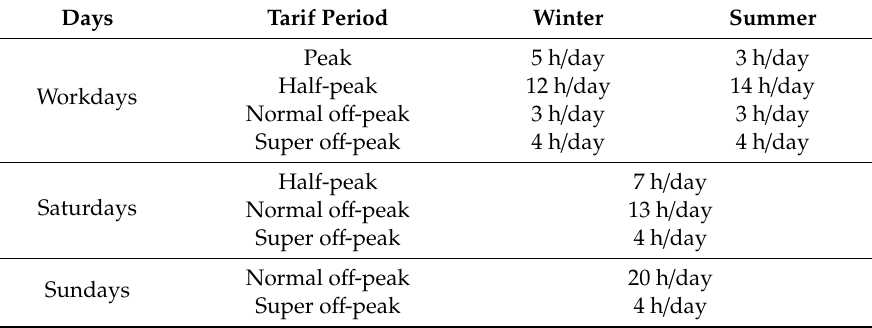
Table 1. Time-of-day tari ff periods (weekly